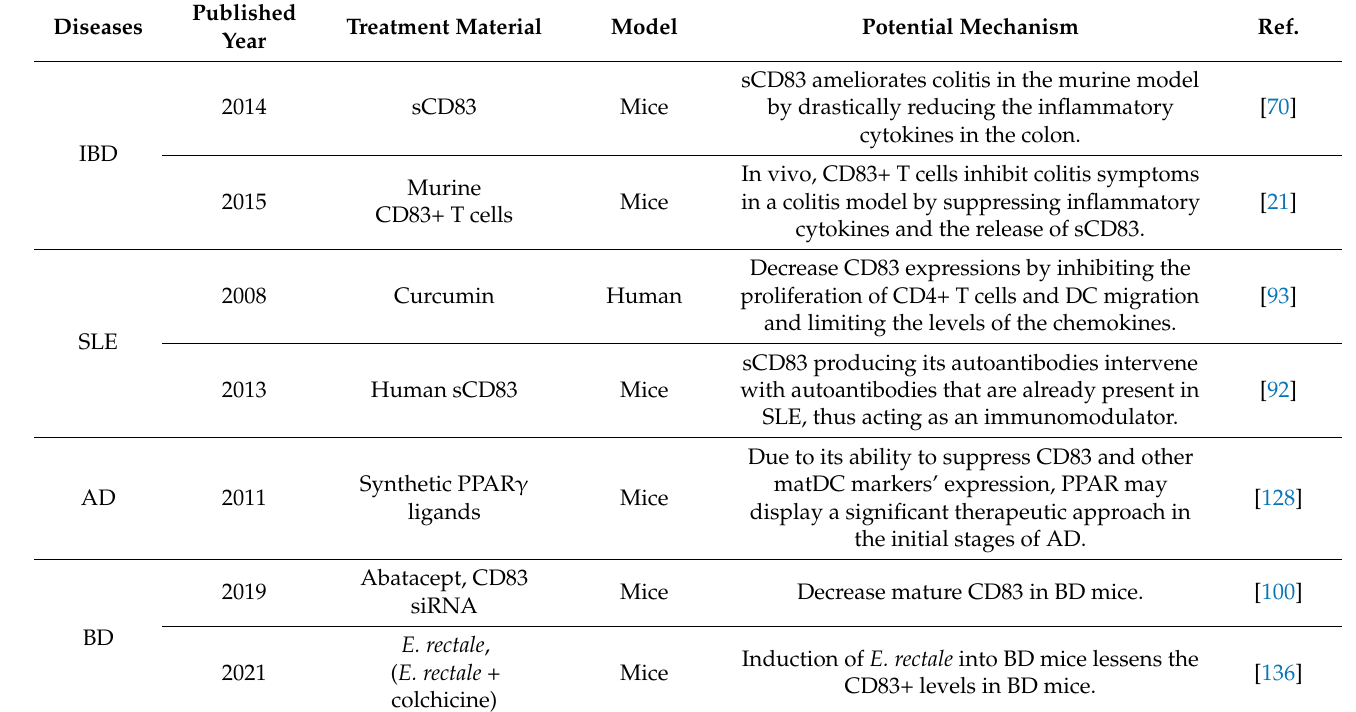
Table 2. Potential anti-CD83 therapeutics in inflammatory